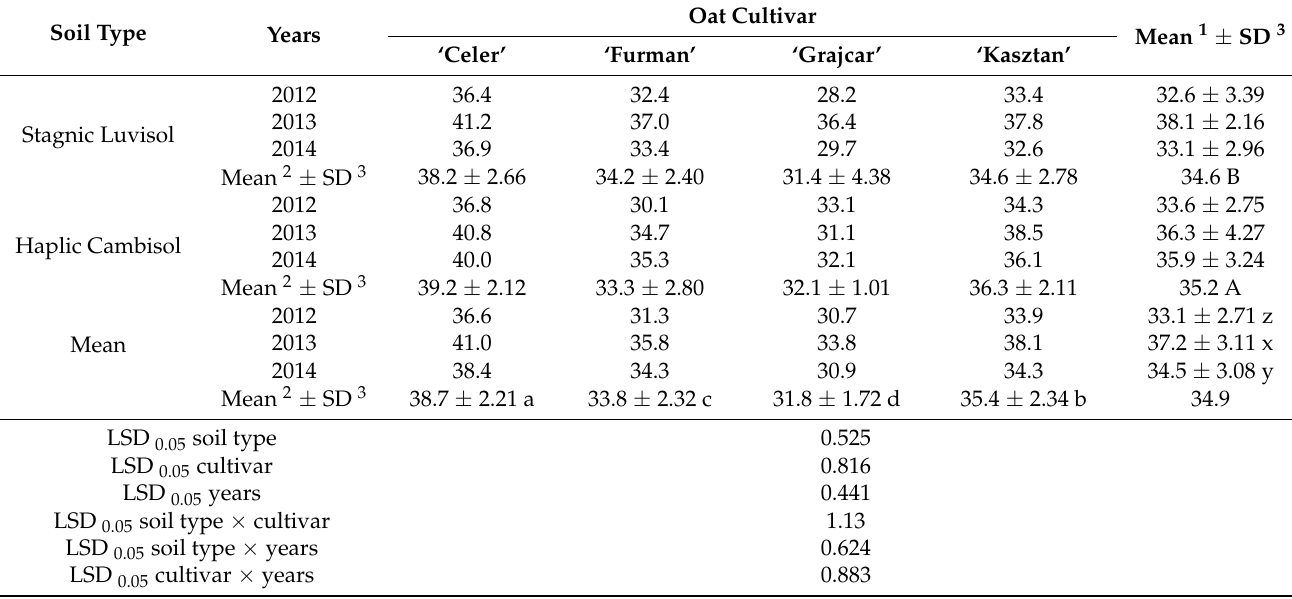
Table 12. 1000-grain mass (g) of oat in the mixture with vetch depending on the soil type (factor I), oat cultivar (factor II), and study years (factor